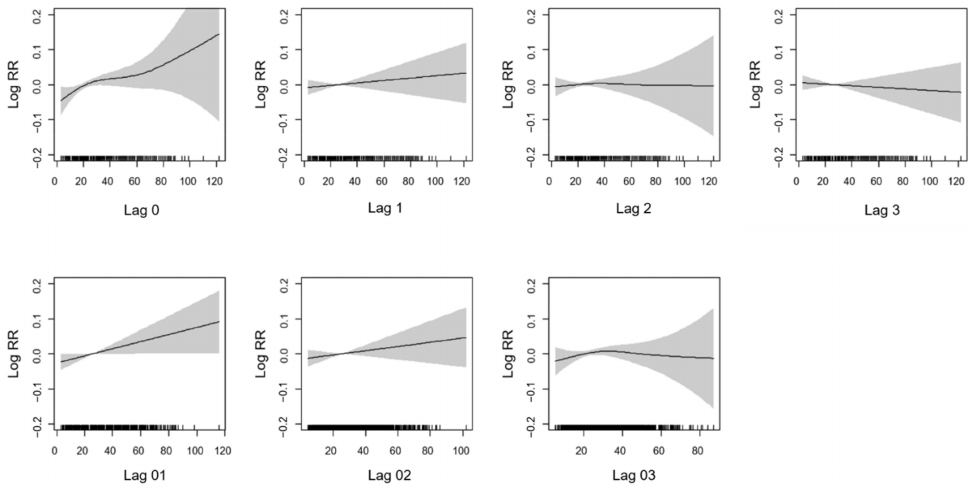
Figure 1. The exposure-response curve for the association between concentration of PM2.5 and AMI over lag days. The black line is the log relative risk, and the gray area is the 95% confidence intervals of the risk